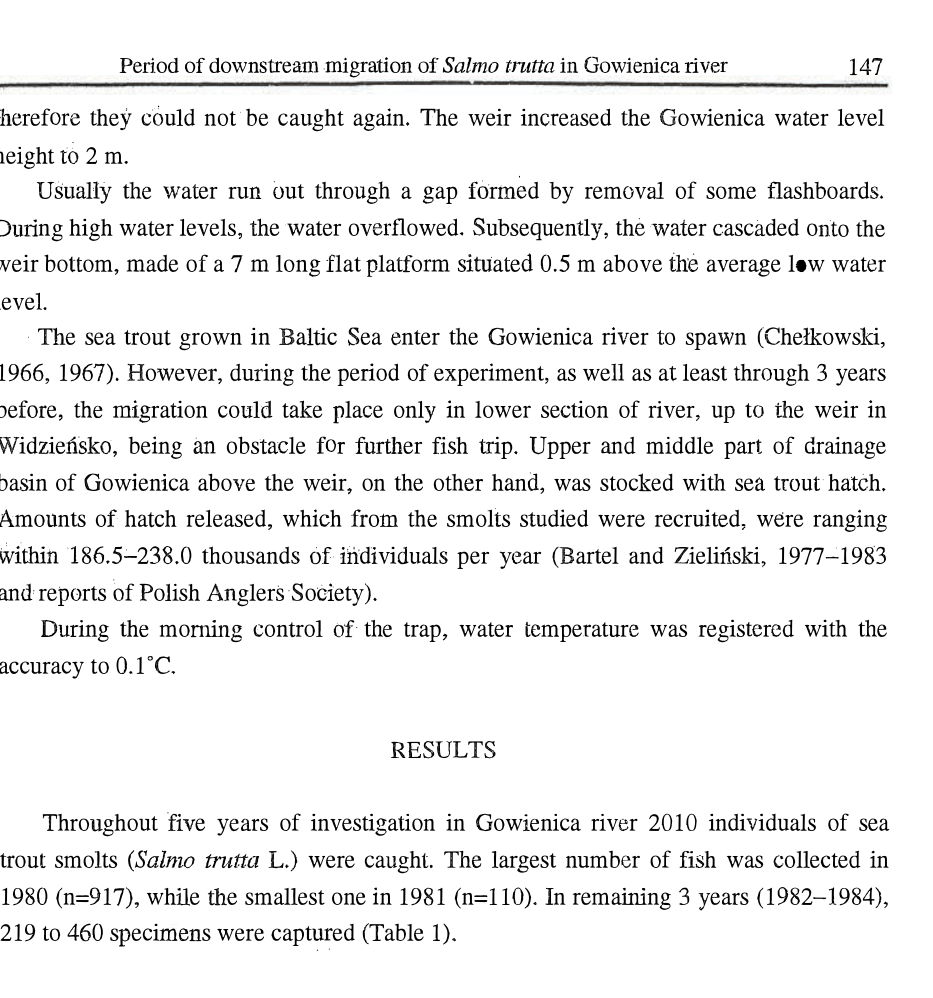
Number of sea trouts. smolt� captured in Gowienica river during the downstream migration